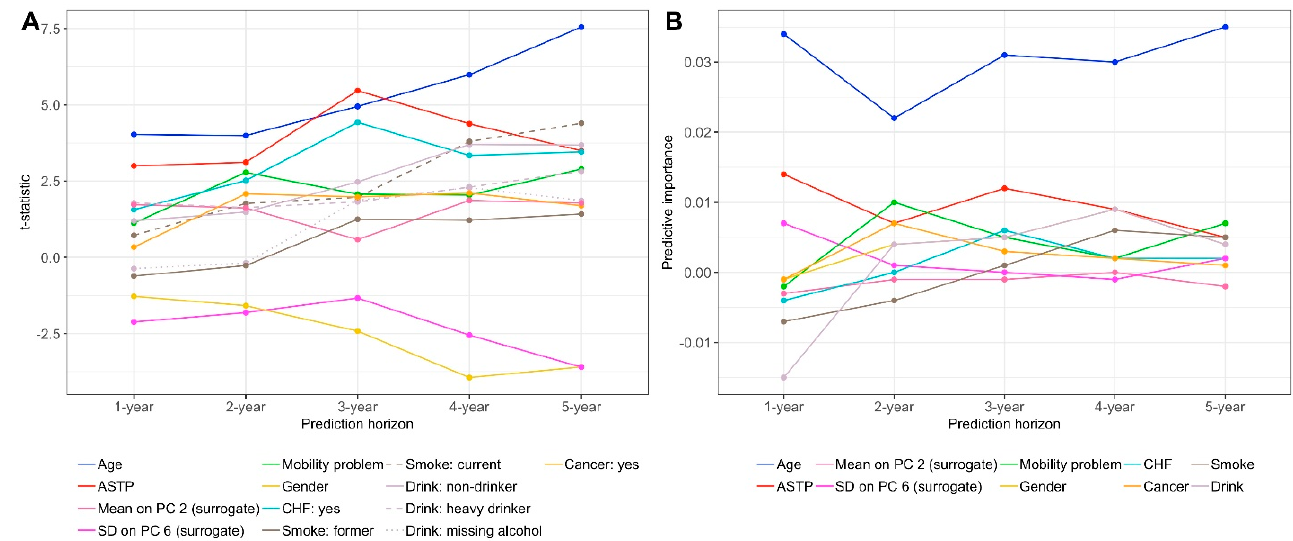
Figure 2. ( A ) The t-statistic values of the combined model coefficients in each prediction horizon. Each line corresponds to a t-statistic coefficient value (y-axis) as a function of the horizon prediction model (x-axis). ( B ) Predictive importance of each variable in the combined model measured by the difference between the CV-AUC of the full combined model and the combined model without that variable across prediction horizons.